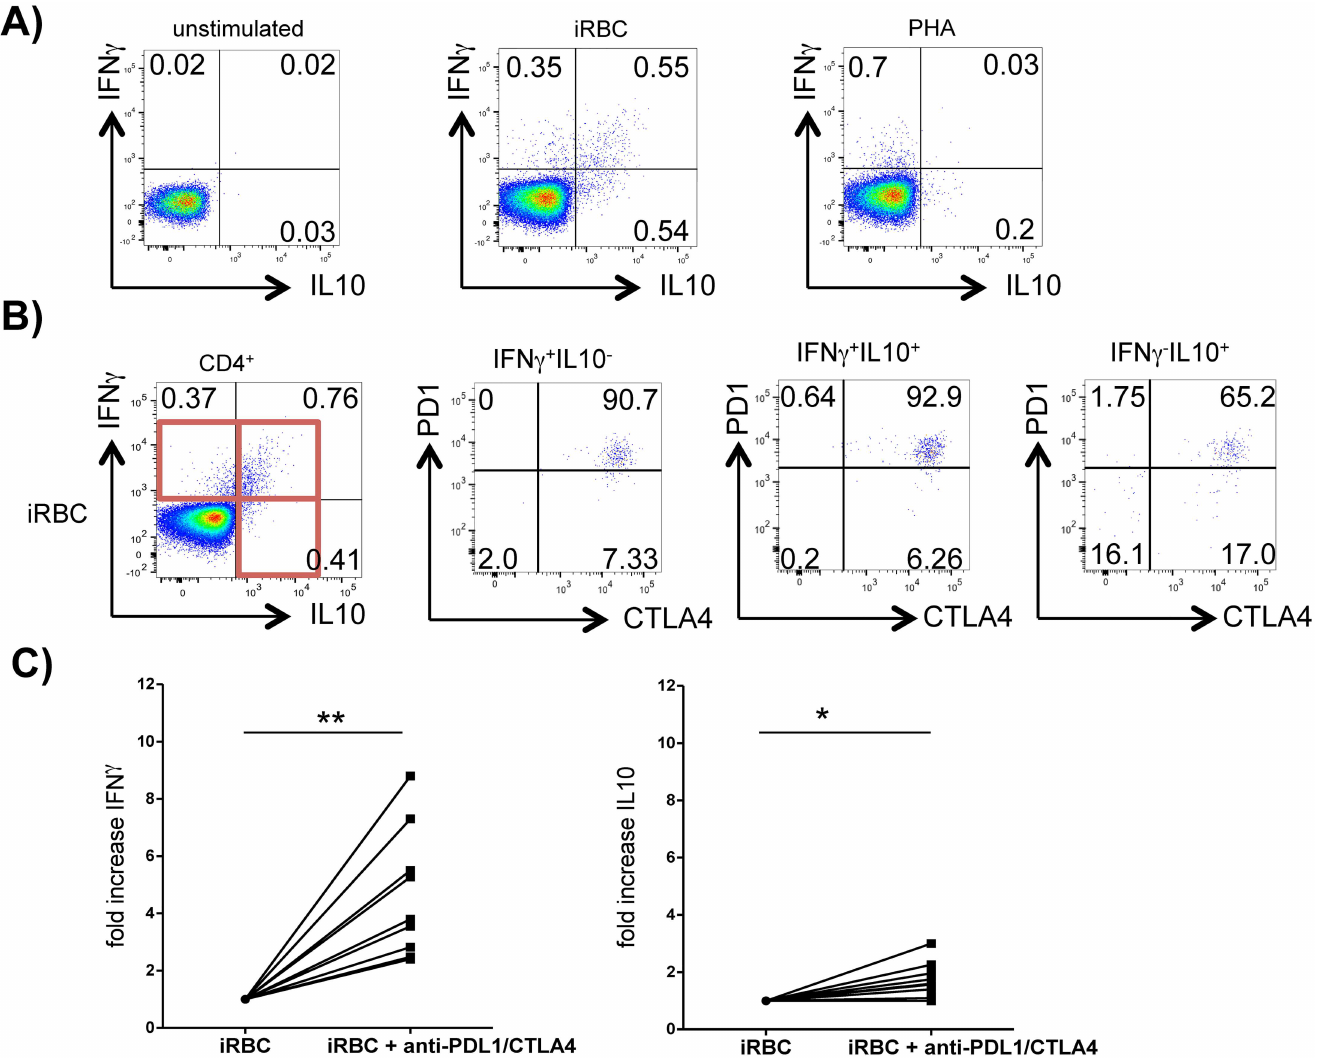
Fig 3. PD1 + CTLA4 + CD4 + T cells coproduce IFN γ and IL10. PBMC from patients with acute malaria were stimulated with iRBC and additionof Brefeldin A/Monensin for 18h. Stimulation without antigen(medium only) and with uninfectedred blood cells (uRBC) served as negative controls. PHA was used as positive control. A) Dotplots show intracellular staining for IFN γ and IL10 in response to medium only (left), iRBC (middle) and PHA (right) after gating for CD4 + T cells. One representative donor with acute malaria out of 11 is shown. Gating strategies for cytokine productionare shown in S7 Fig. B) IFN γ + and IL10 + CD4 + T cells were further analyzedfor expressionof CTLA4 and PD1. One representative patient out of 11 is shown. C) PBMC were stimulated for 120hrs with iRBC and with/without addition of blockingantibodiesagainst CTLA4 and PDL1. IL10 and IFN γ were measured in culture supernatants by ELISA. Fold-increase of cytokine productionwas calculated by dividingthe net iRBC-specific cytokine production with blockadeof CTLA4/PDL1 by net-cytokine productionwithout antibody blockade. P = 0.004 (IFN γ ) and P = 0.016 (IL10), using the Wilcoxon matched pairs test on net-cytokine concentration